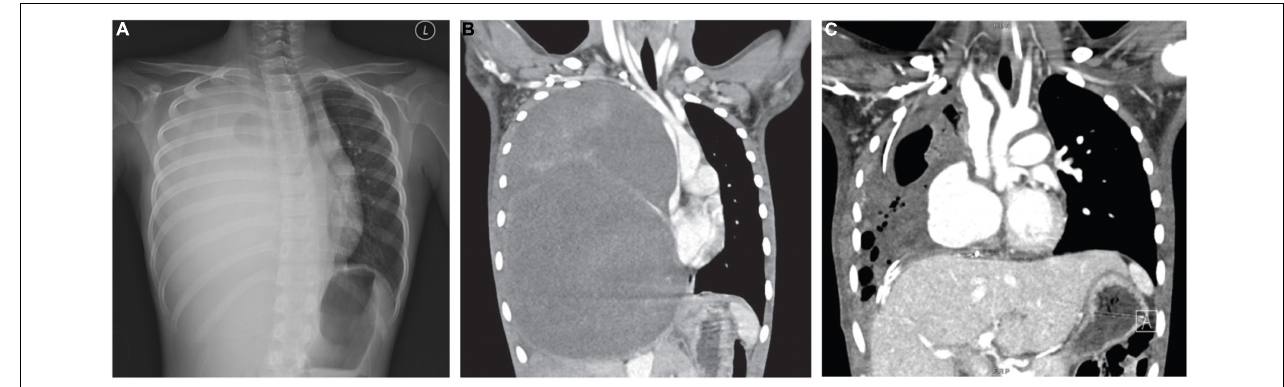
FIGURE 1 | (A) CXR and (B) CT revealed a giant mass of 16.9 cm × 15.2 cm × 22.4 cm (AP × W × H) expanding the right thorax with significant compression on the mediastinum. (C) Post-operative CT indicates partial re-expansion of the right lung.